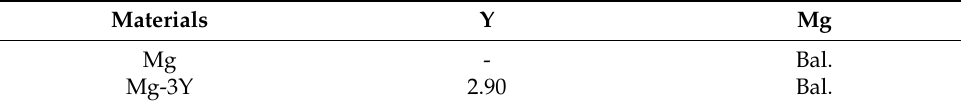
Figure 2. The reduction per pass, accumulated reduction, and sheet thickness as a function of rolling pass (red circle, blue triangle and green box represent reduction per pass, accumulated reduction and sheet thickness respectively). Table 1. Chemical compositions of the as-cast materials